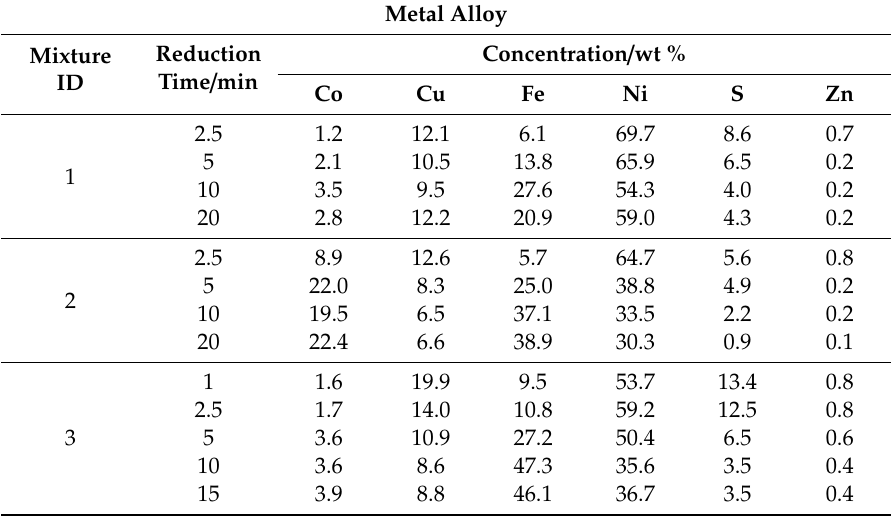
Table A2. Average elemental concentrations (wt %) in the metal alloy as a function of time in di ff erent